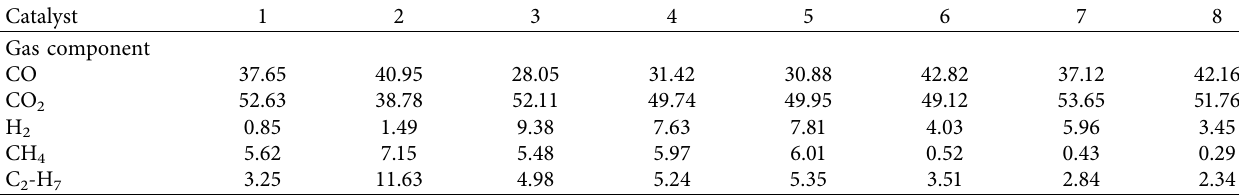
Table 5: Influence of metal-modified 13X zeolite catalysts on the gas